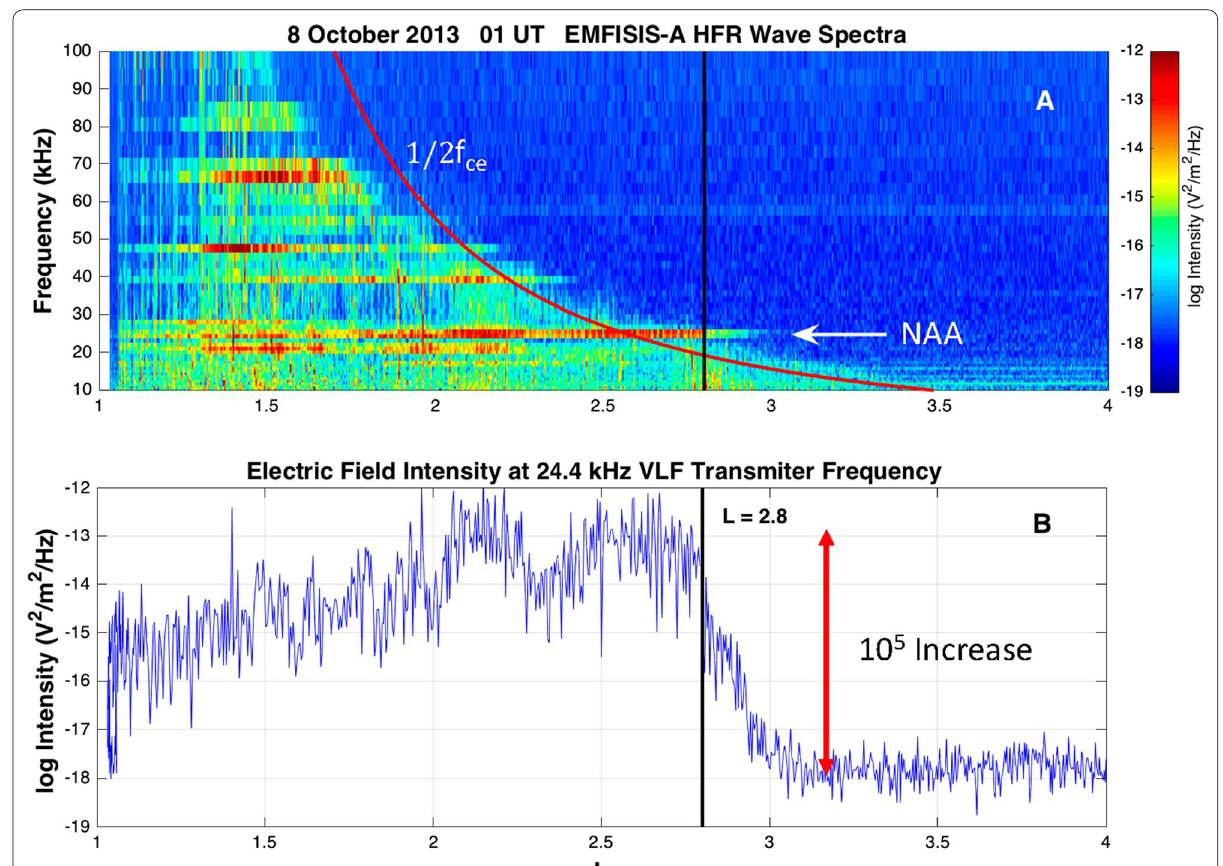
Fig. 9 EMFISIS observations reveal the confinement of the signals from ground-based VLF transmitters to a magnetically confined bubble surrounding Earth. a Spectra of wave electric field intensity are plotted versus L for a perigee pass in October 2013 at a time when the plasmapause was beyond L 4. The red curve denotes 0.5 fce. An arrow denotes the strong VLF transmitter signal near 24 kHz. b Electric field intensity (| E |^2) at = the transmitter frequency increased by 10^5 over 0.5 RE as Van Allen Probe A moved inward across the outer edge of the VLF bubble (From Foster et al.